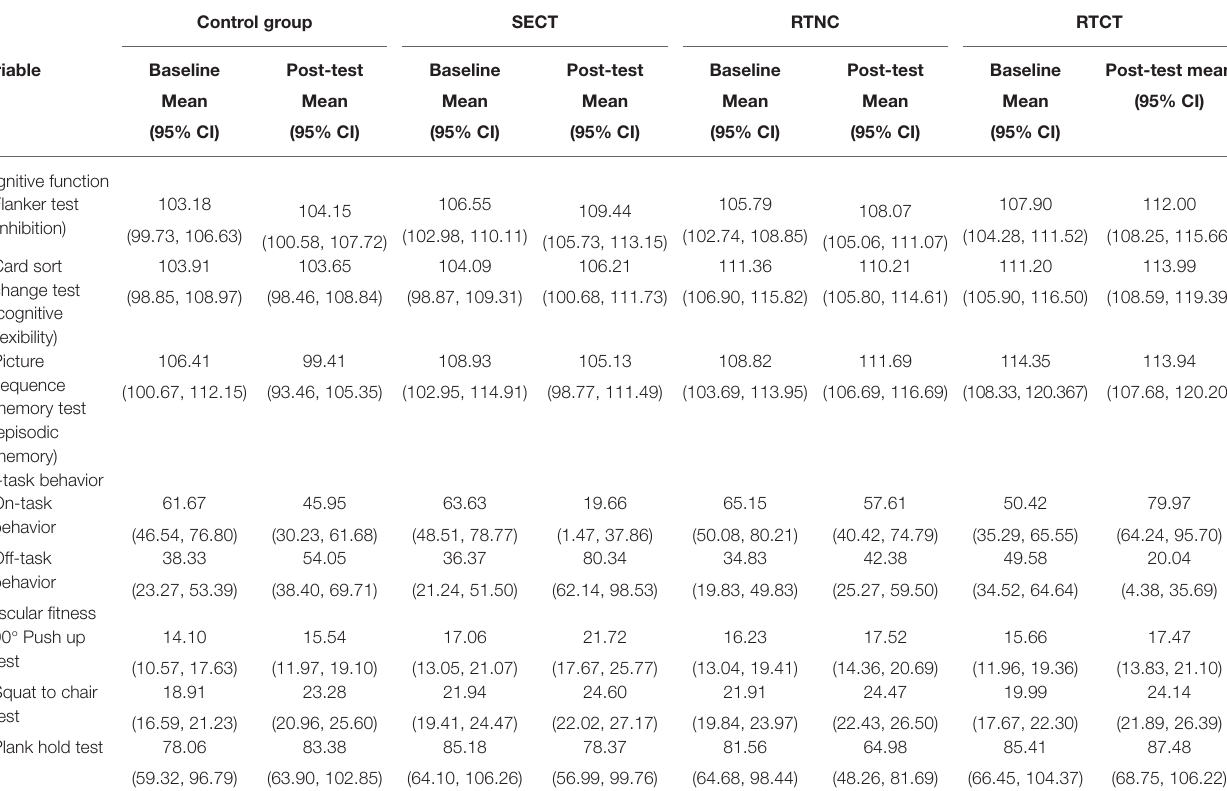
TABLE 2 | Summary of outcome